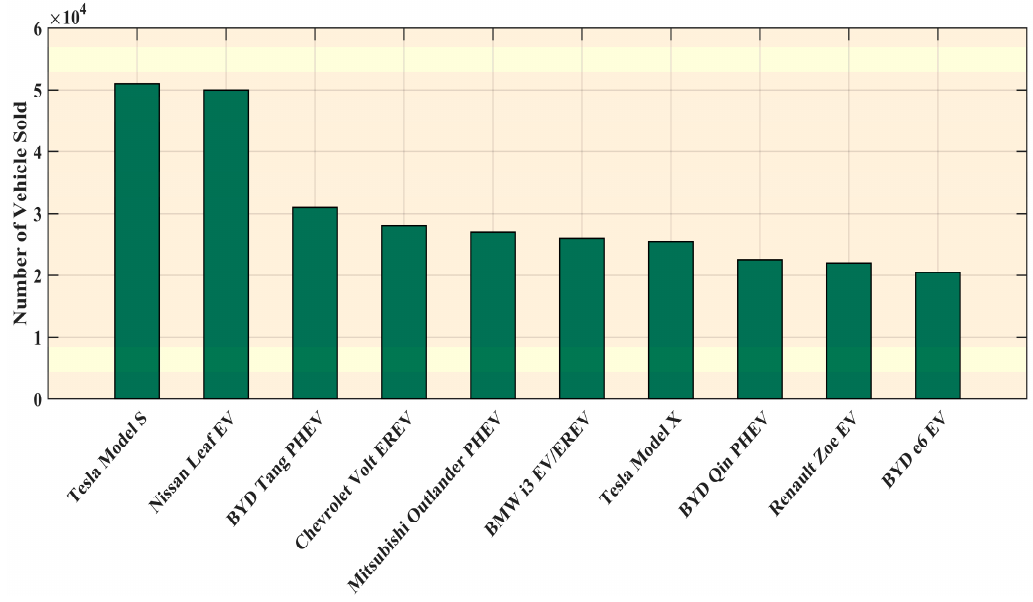
Figure 76. Top ten best-selling EVs globally in 2016. Data from [191].